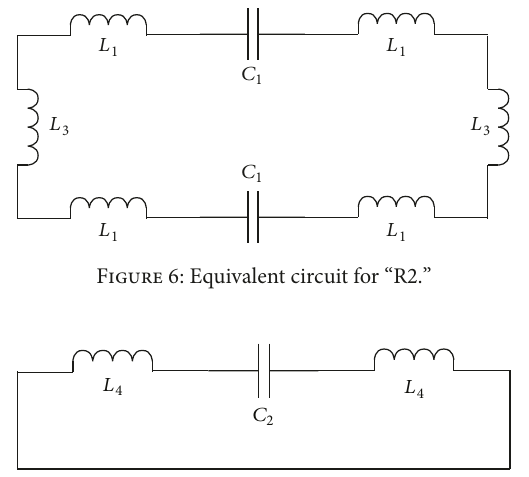
Figure 7: Equivalent circuit of electric resonator.